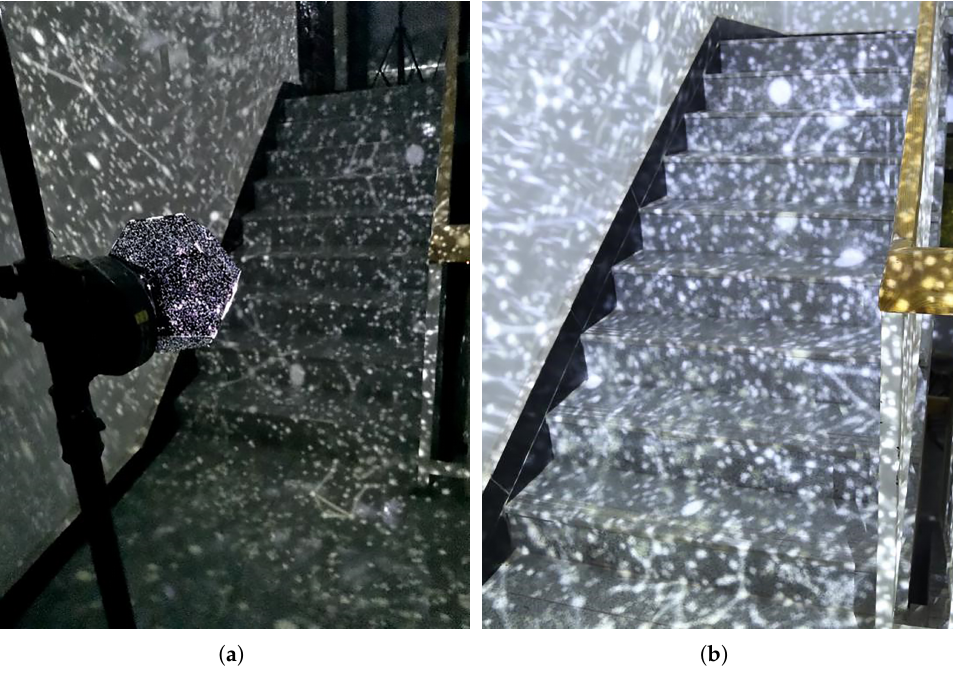
Figure 3. Our devices and the environment in the experiment. ( a ) One light source fixed on a tripod and the spark pattern mapped to the scene. ( b ) One camera image used in the reconstruction.